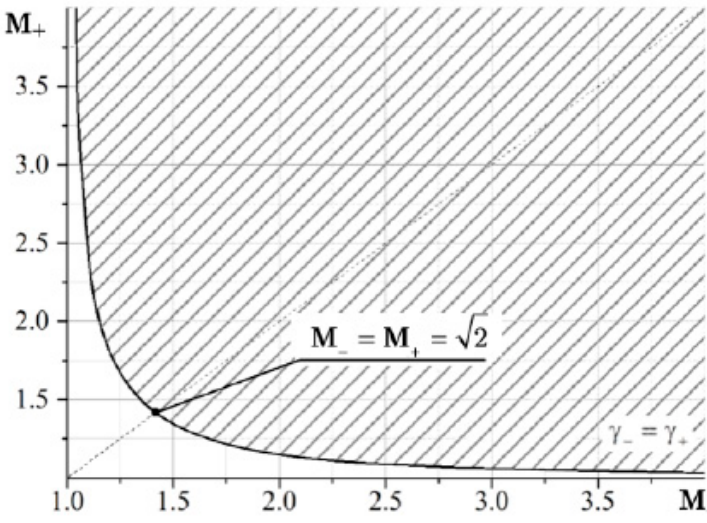
Figure 5. Domain of existence of characteristic refraction in air (the shaded area).